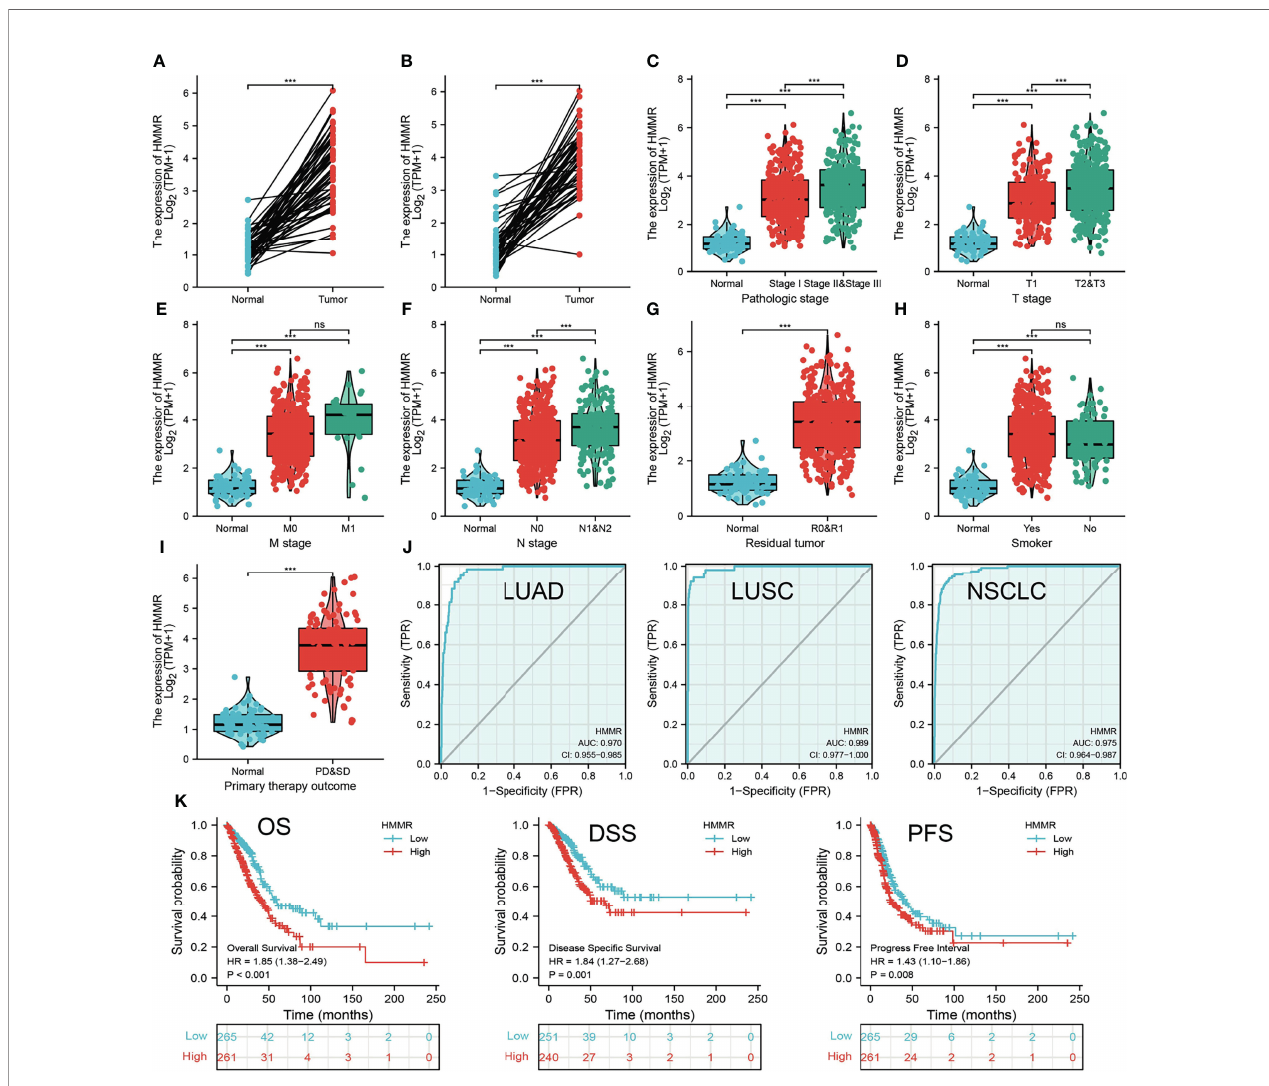
FIGURE 3 | HMMR was up-regulated in LUAD. (A, B) The expression of HMMR in LUAD examine by TCGA databases. (C – I) The correlation between HMMR expression and clinical features in LUAD. (J) The ROC curve of HMMR in LUAD. (K) The prognosis of HMMR in LUAD examine by TCGA database. Overall survival